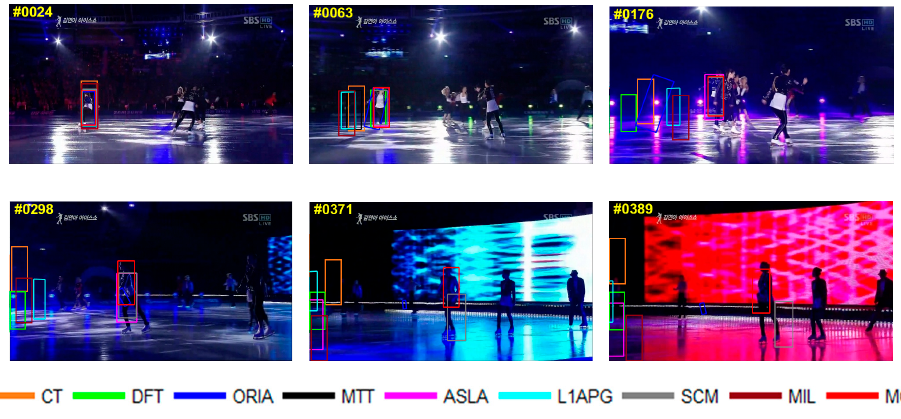
Figure 15. Tracking results on Skating1 .